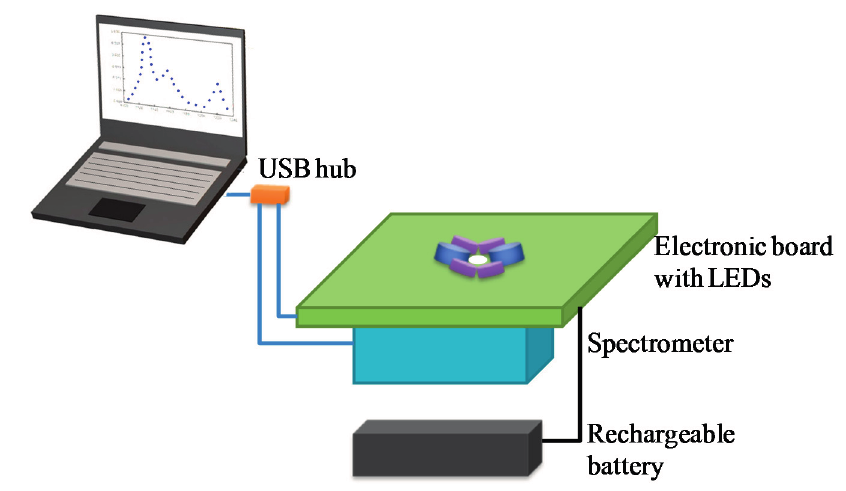
Figure 7. Instrument block